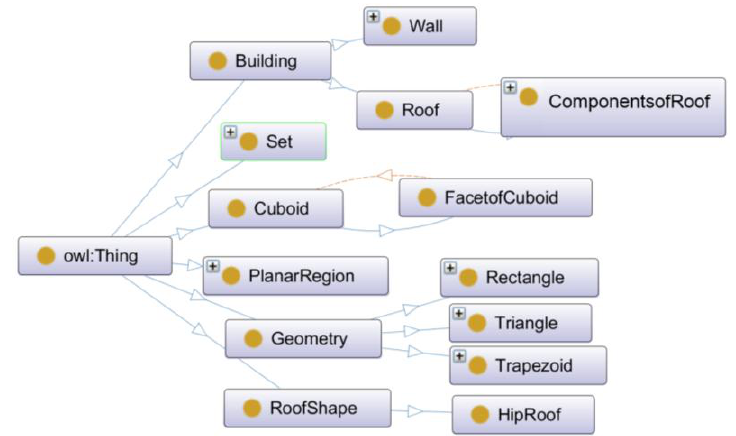
ISPRS Int. J. Geo-Inf. 2018 , 7 , 28